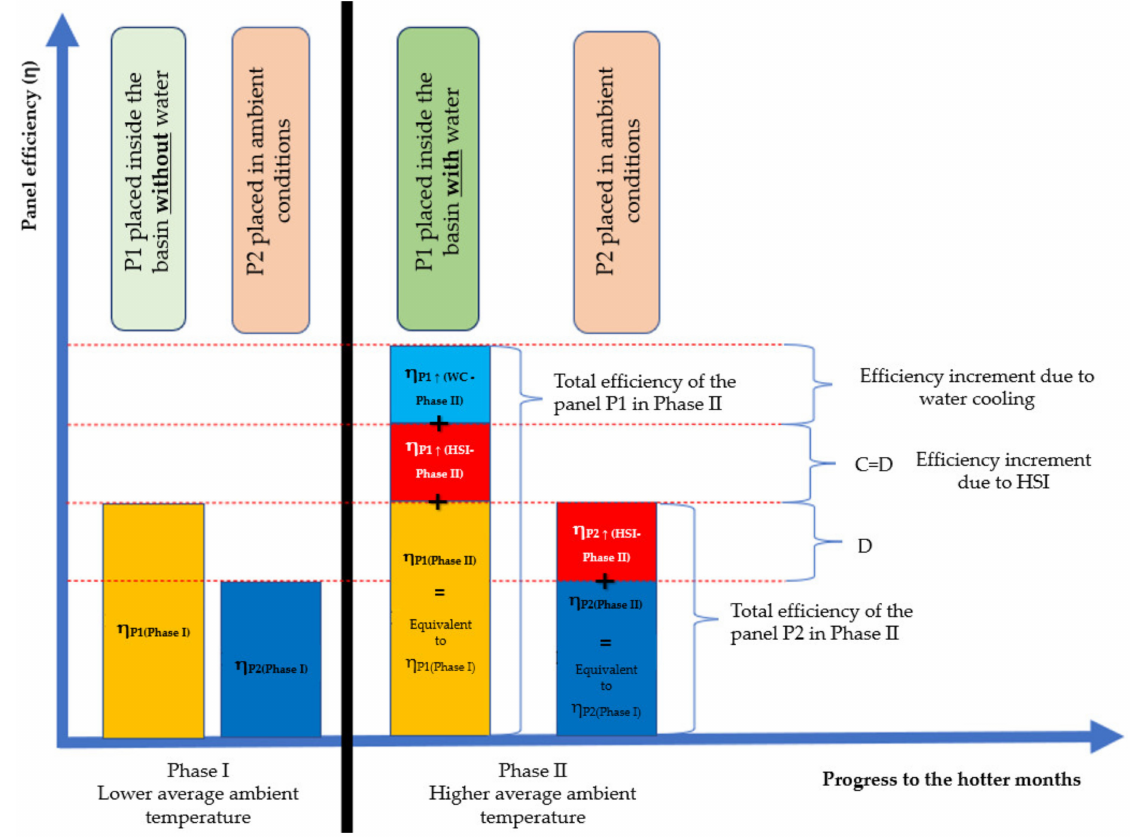
Figure 9. Panels efficiency increment scheme, in phase II- two phenomenon have affected the efficiency increment (1) availability of higher solar insolation (increment observed in both panels) and (2) due to water cooling effect (only observed in the case of P1 placed above